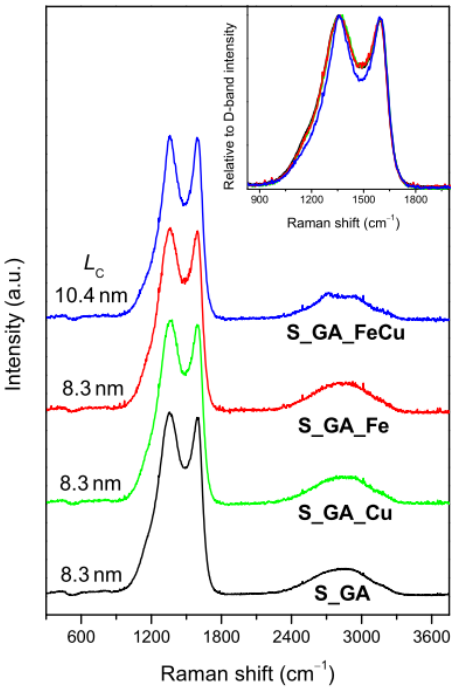
Figure 2. Micro-Raman spectra of the investigated catalysts (the average size of the graphitic crystallites ( L C ), estimated from the G/D intensity ratio [31] is reported). Inset: comparison of the D- and G-band regions of the spectra.